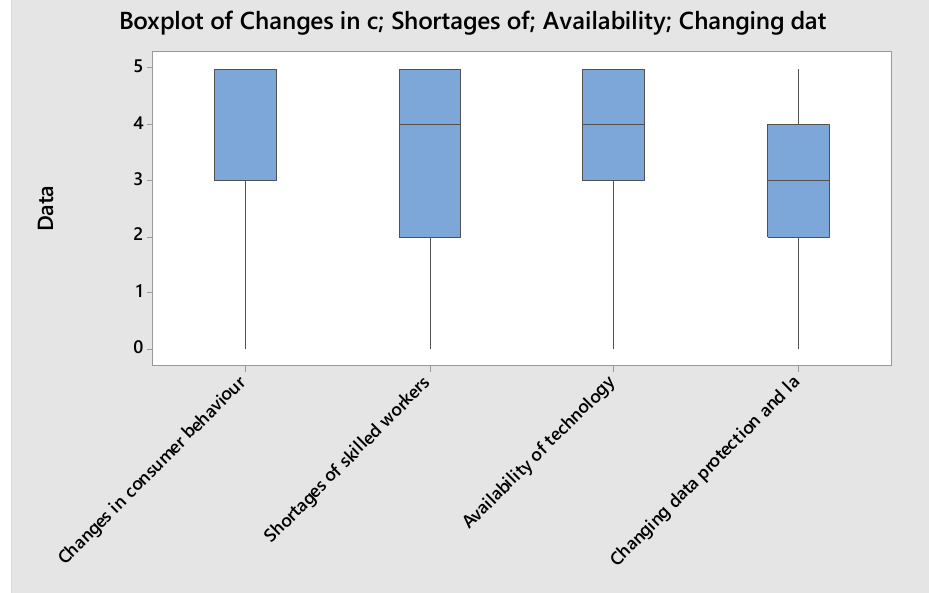
Figure 6. Box plot: comparison of the importance of the analyzed indicators in trends: innovative solutions in logistics and digitalization. Table 12. Anderson–Darling normality test results—development indicators.